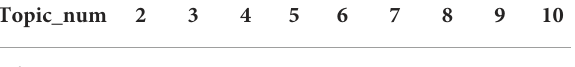
TABLE 3 Average consistency of the number of different topics.